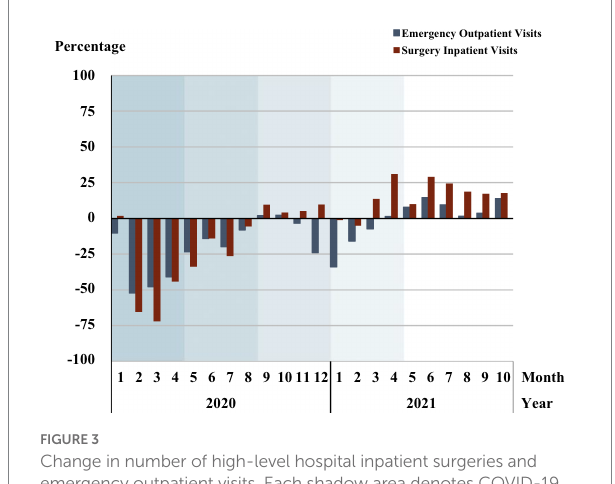
FIGURE 3 Change in number of high-level hospital inpatient surgeries and emergency outpatient visits. Each shadow area denotes COVID-19 phase 1 to phase